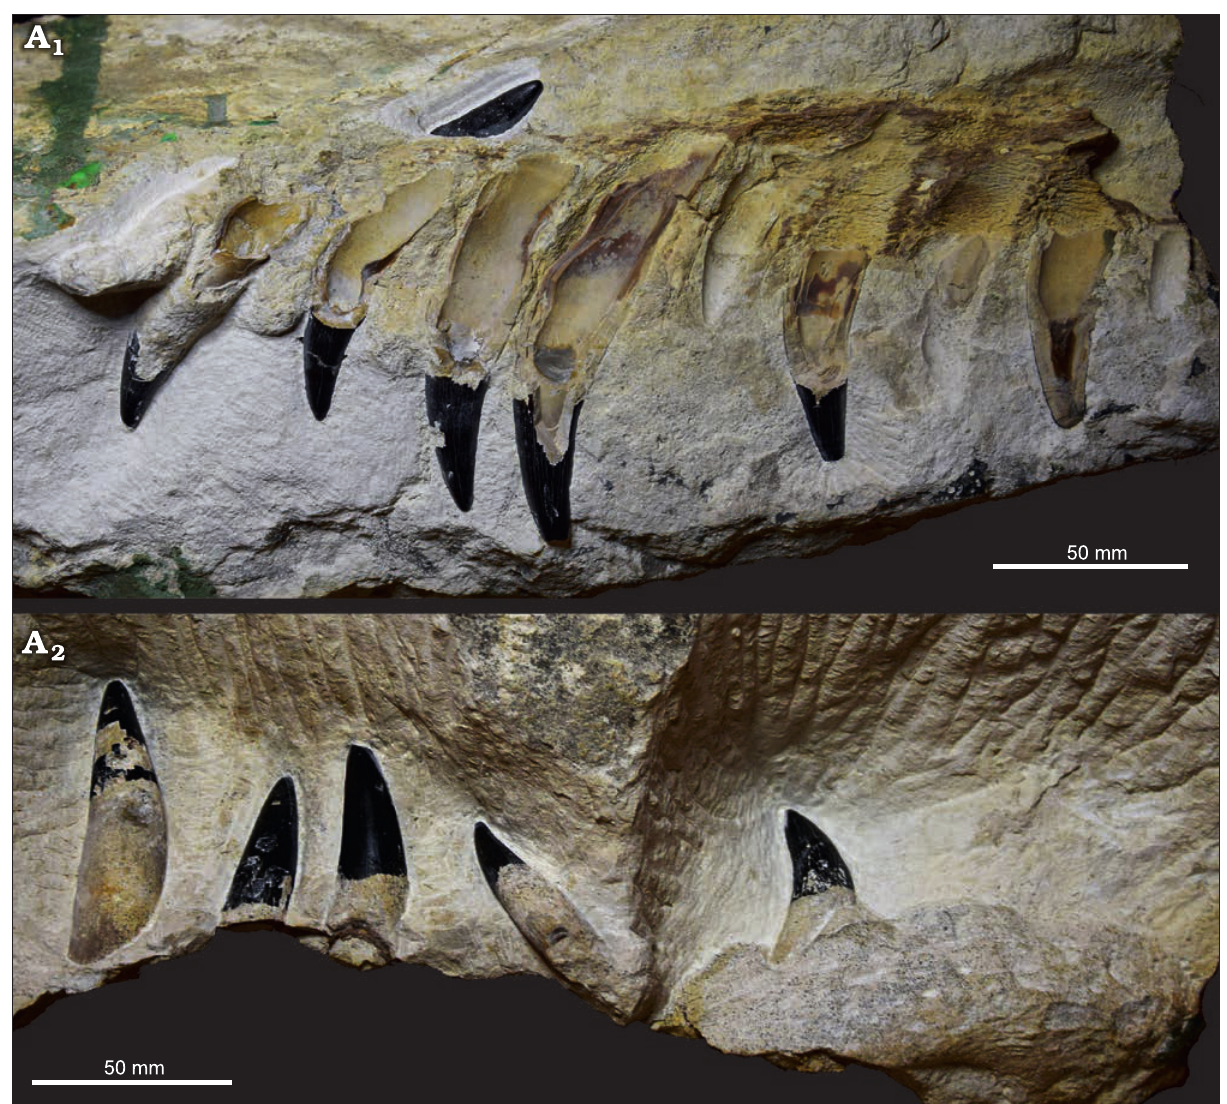
Fig. 7. Jaw fragments of an indeterminate metriorhynchid (MZ VIII Vr-72) from an unknown locality and age, preserved on the opposite sides of a lime- stone block: the “premaxilla” (A 1 ) and the “dentary” (A 2 ) of Tyborowski and Błażejowski (2019a,